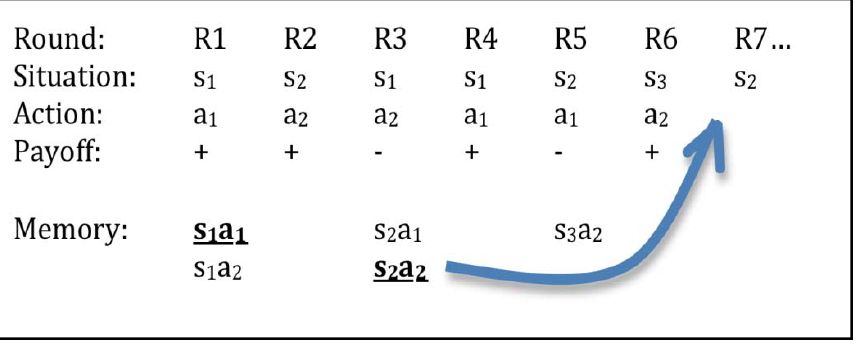
Figure 2. Example of how a decision is based on the retrieval of the most active instance in memory. The most active instance is